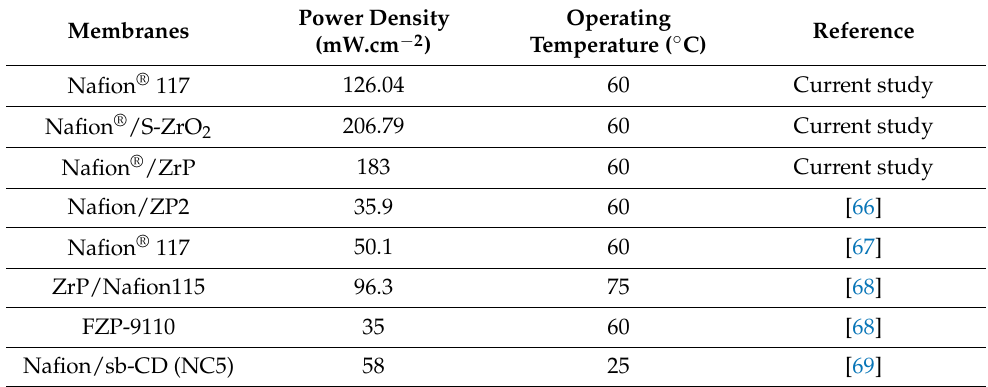
Table 3. A comparison of the power density of the synthesised nanocomposite membranes and commercial Nafion ® 117 in this investigation with those of membranes reported on in various research